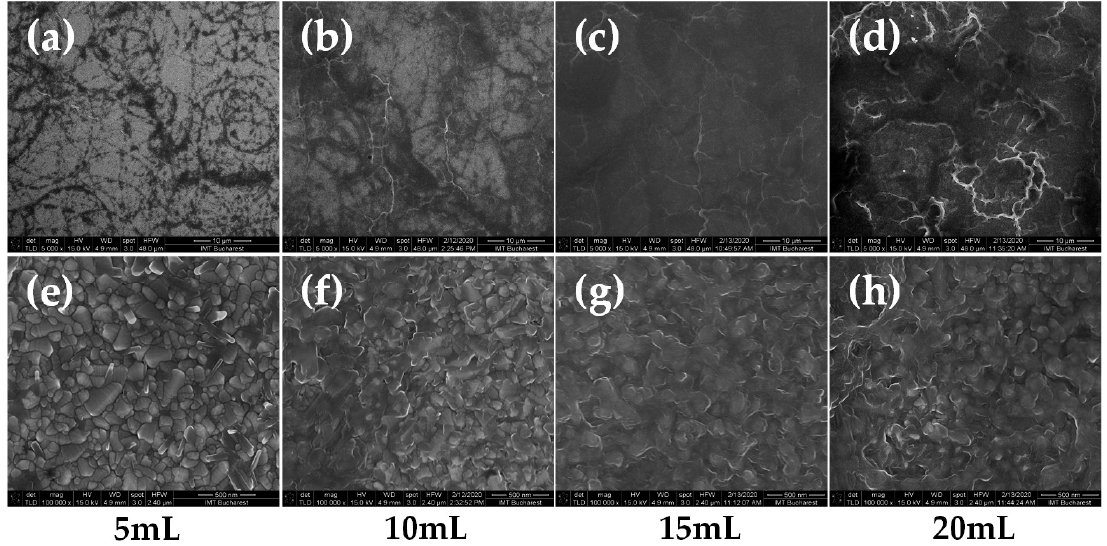
Figure 4. Field-emission scanning electron microscope (FE-SEM) images of the nanostructured V 2 O 5 films after annealing ( a – d ) FE-SEM micrographs of the 5, 10, 15, and 20 mL precursor quantities deposited films at 5000× magnification (scale size 10 μ m); ( e – h ) FE-SEM micrographs of the 5, 10, 15, and 20 mL precursor quantities deposited films at 100,000× magnification (scale size 500 nm).